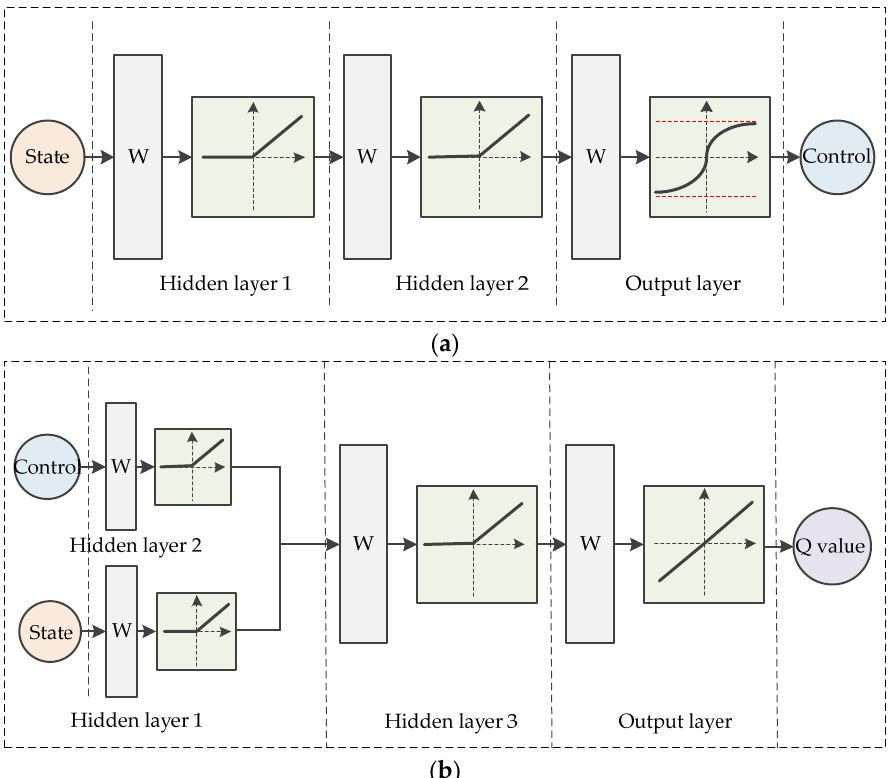
Figure 5. The architectures of policy and evaluation networks. ( a ): the policy network structure; ( b ):